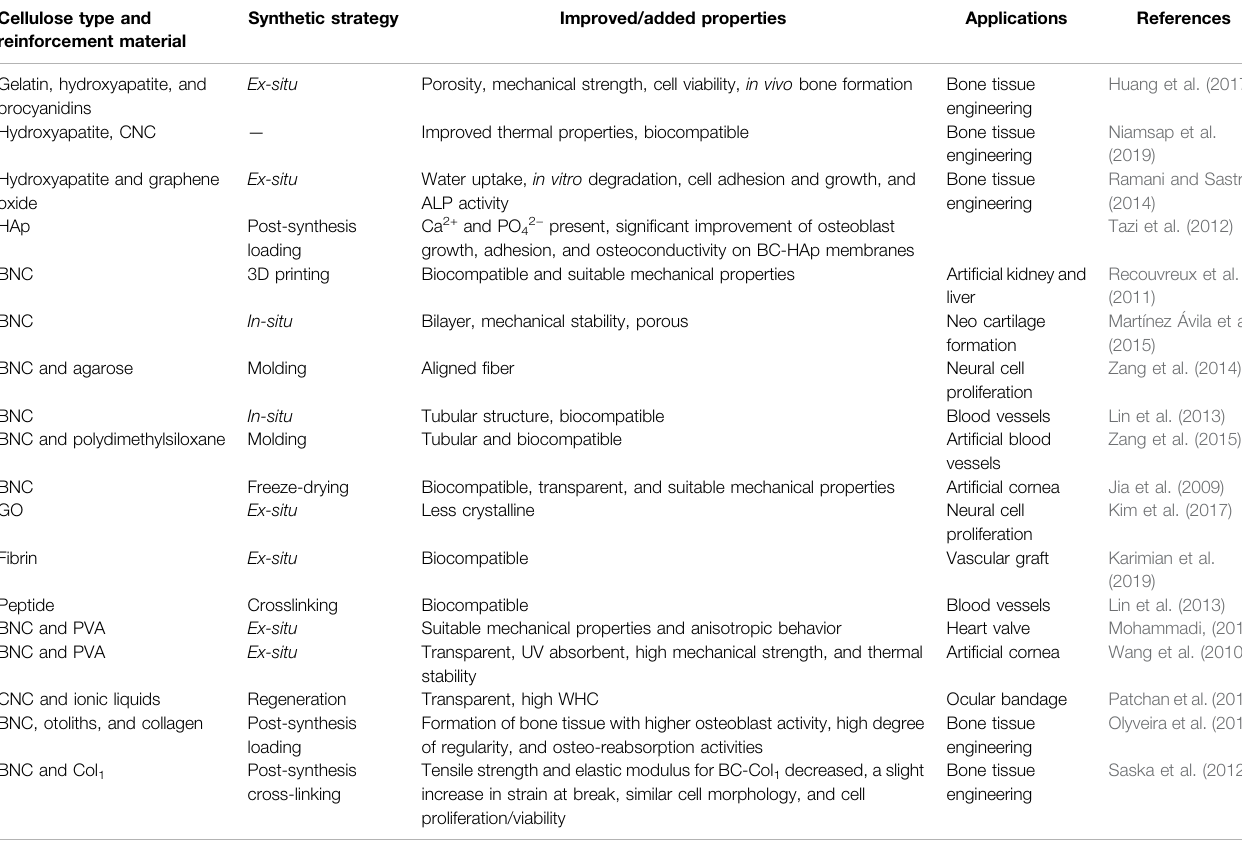
TABLE 5 | The improved properties and development of synthetic organs prepared from nanocellulose-based composites. Cellulose type and reinforcement material